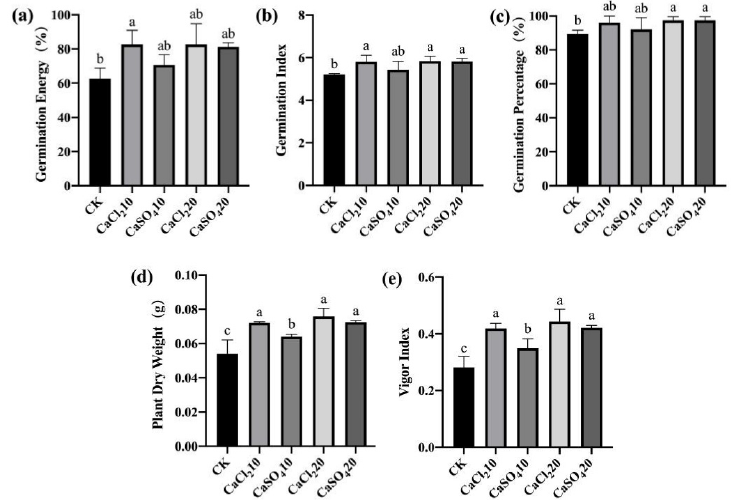
Figure 9. Exogenous Ca 2+ enhanced the resistance of high-vigor maize seeds to F. graminearum . ( a ) germination energy (%), ( b ) germination index, ( c ) germination percentage (%), ( d ) dry weight of single plant (g), ( e ) vigor index. CaCl 2 10/20, 10/20 mmol/L CaCl 2 solution; CaSO 4 10/20, 10/20 mmol/L CaSO 4 solution; CK, control. Different letters indicate significant differences among different lines (Tukey’s test).